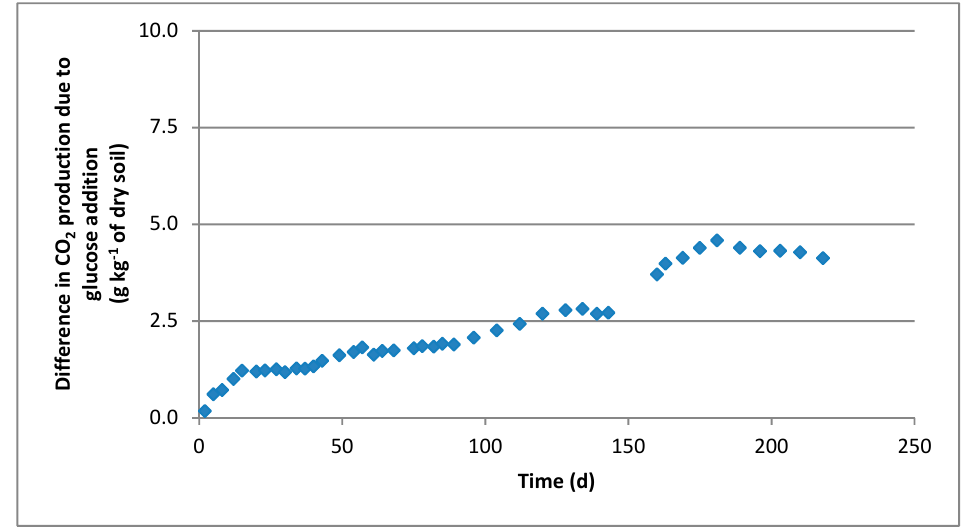
Figure 3. Difference in CO 2 production due to glucose addition.